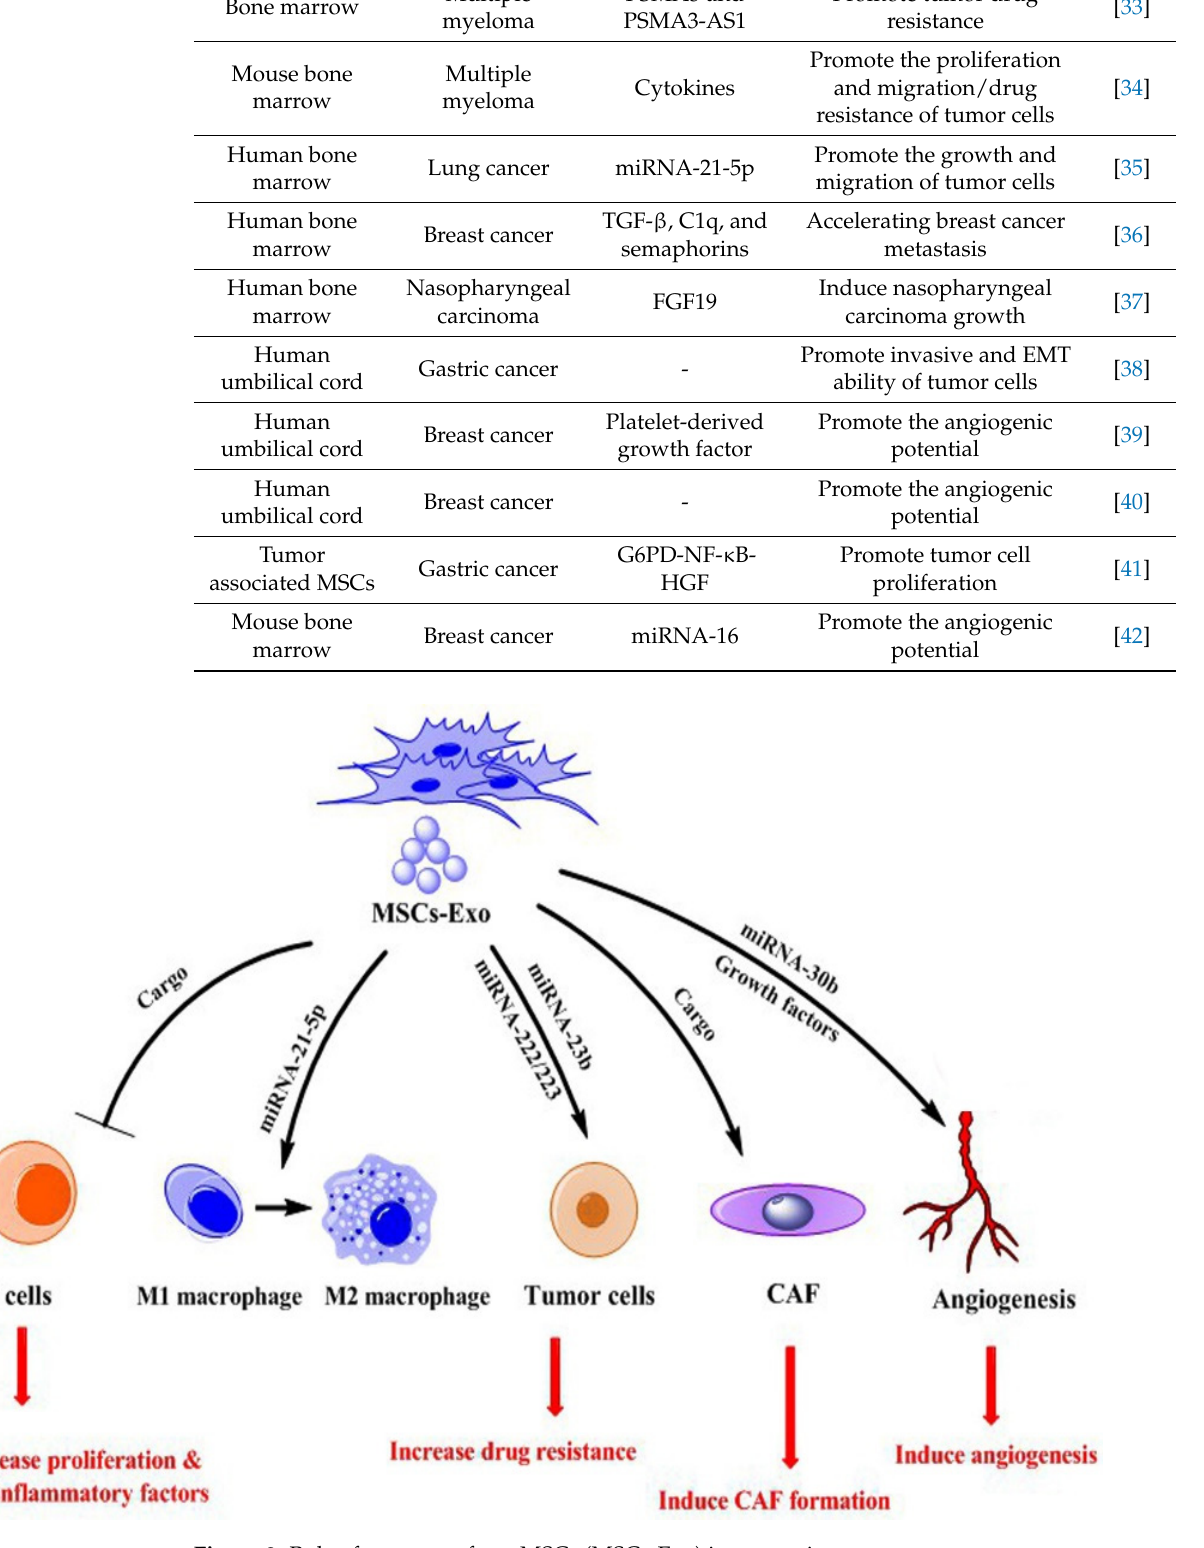
Figure 2. Role of exosomes from MSCs (MSCs-Exo) in promoting tumor.